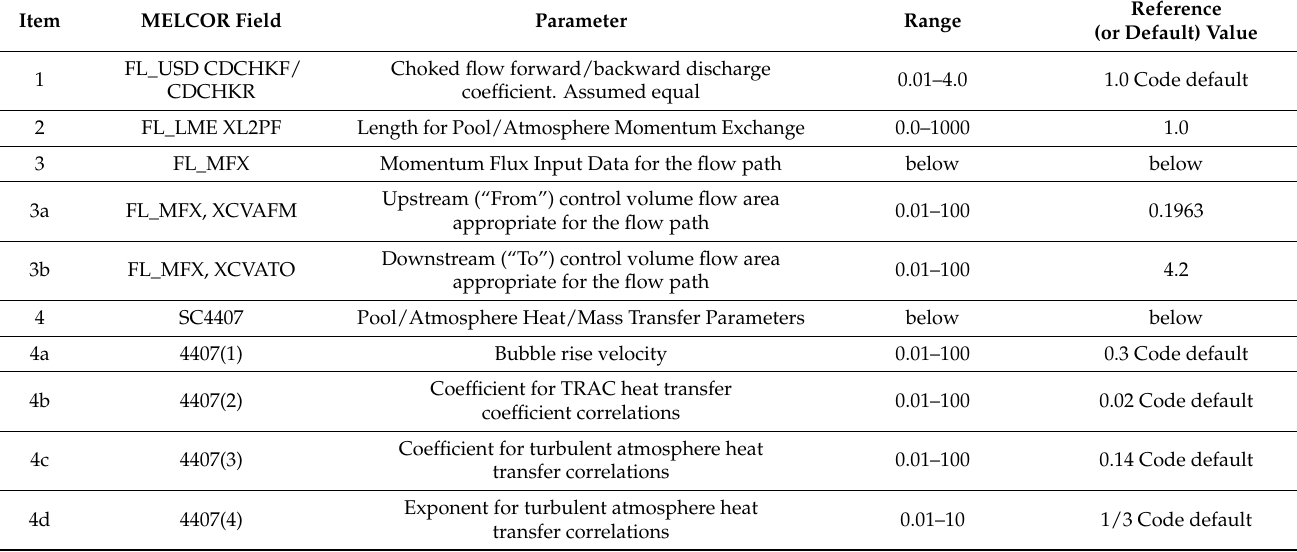
Table 2. List of the sensitivity parameters studied in the initial analysis. The parameters were available in the code version 2.2.15254 and taken from the Manual